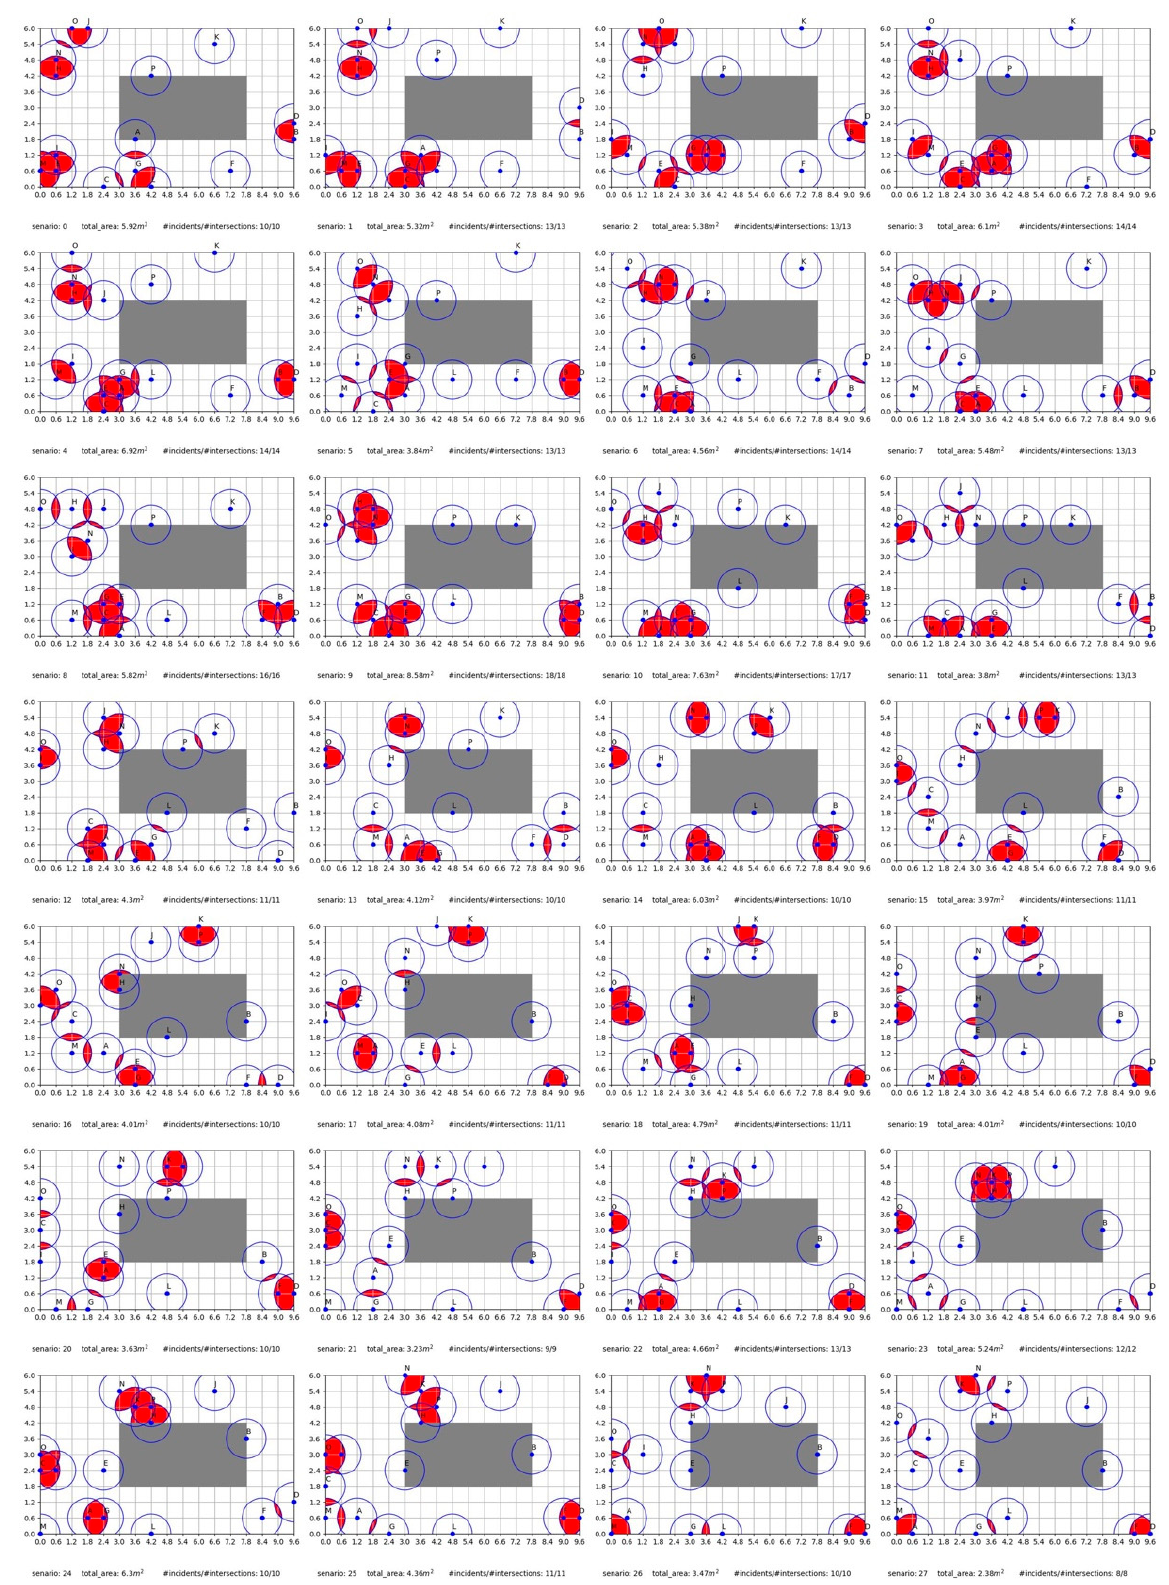
Figure 4. Graphic output showing simulated occupant positioning with the furniture layout for teaching and learning activity 2 (seminar), without contact time consideration.